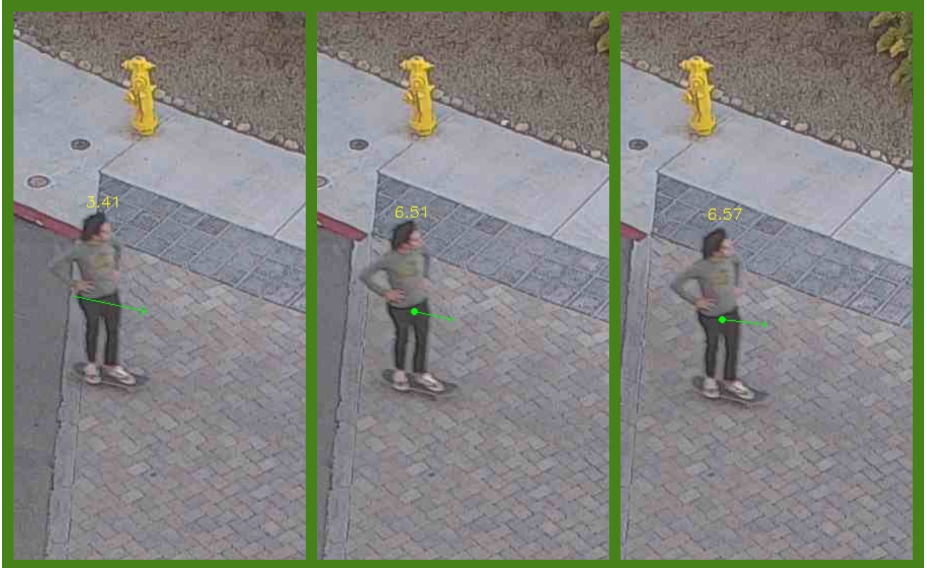
Figure 36. First-order average object velocity estimation to predict time to collision (TTC). Units of numbers shown in yellow are